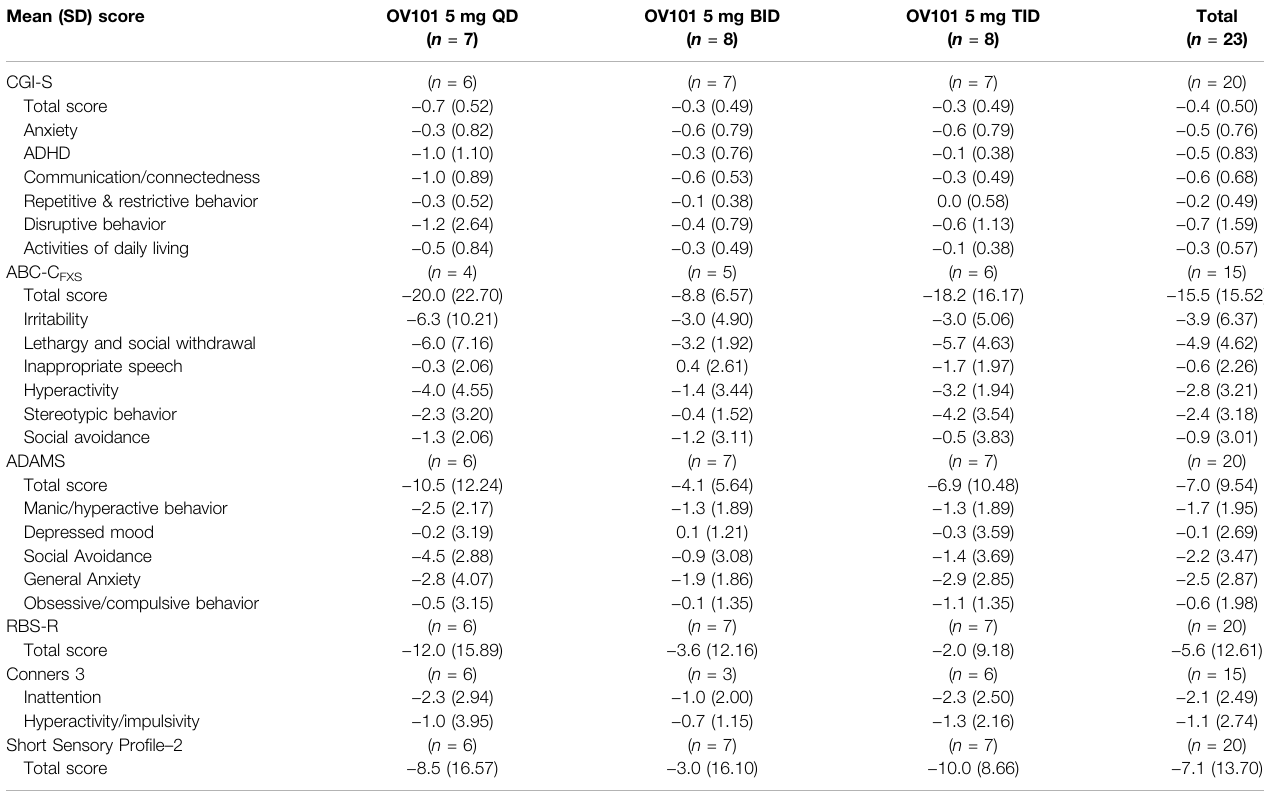
TABLE 4 | Change in secondary ef fi cacy measures from baseline to week 12. Mean (SD) score